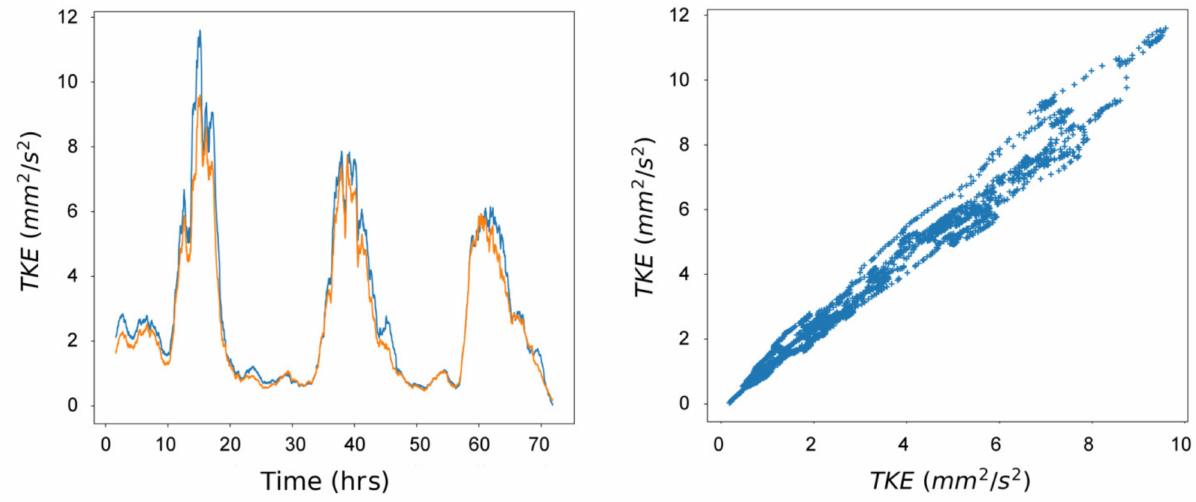
Figure 7. Correlations between the TKE values, derived by two independent methods. Projection of each point on the X and Y axes represent the values, obtained by the coupled-ADCPs and single-ADCP methods